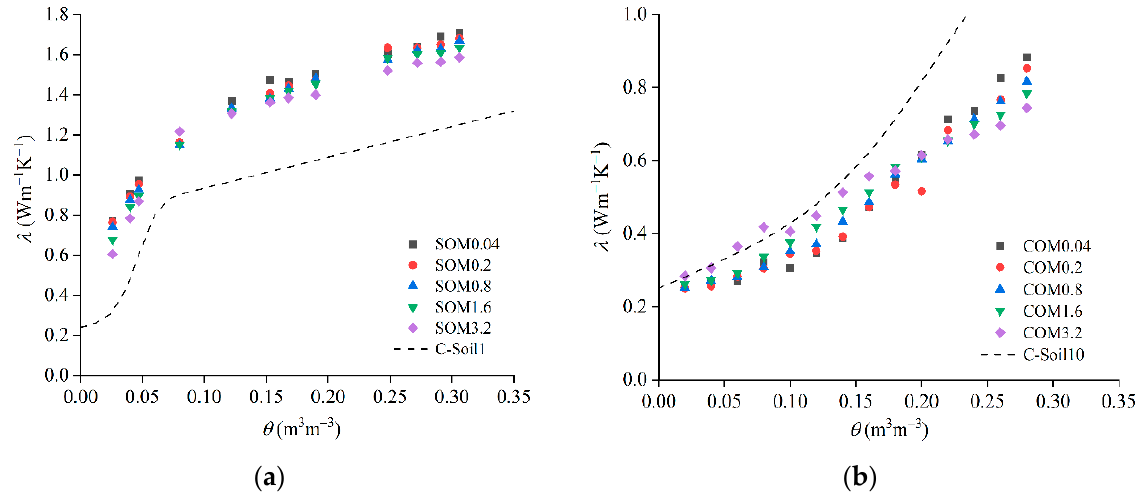
Figure 3. The relationship of λ ~ θ and the curve estimated by the Campbell model for soil with different organic matter contents. Figure ( a ) shows the results of Soil 1, representing sandy soil. Figure ( b ) shows the results of Soil 10, representing clay soil.